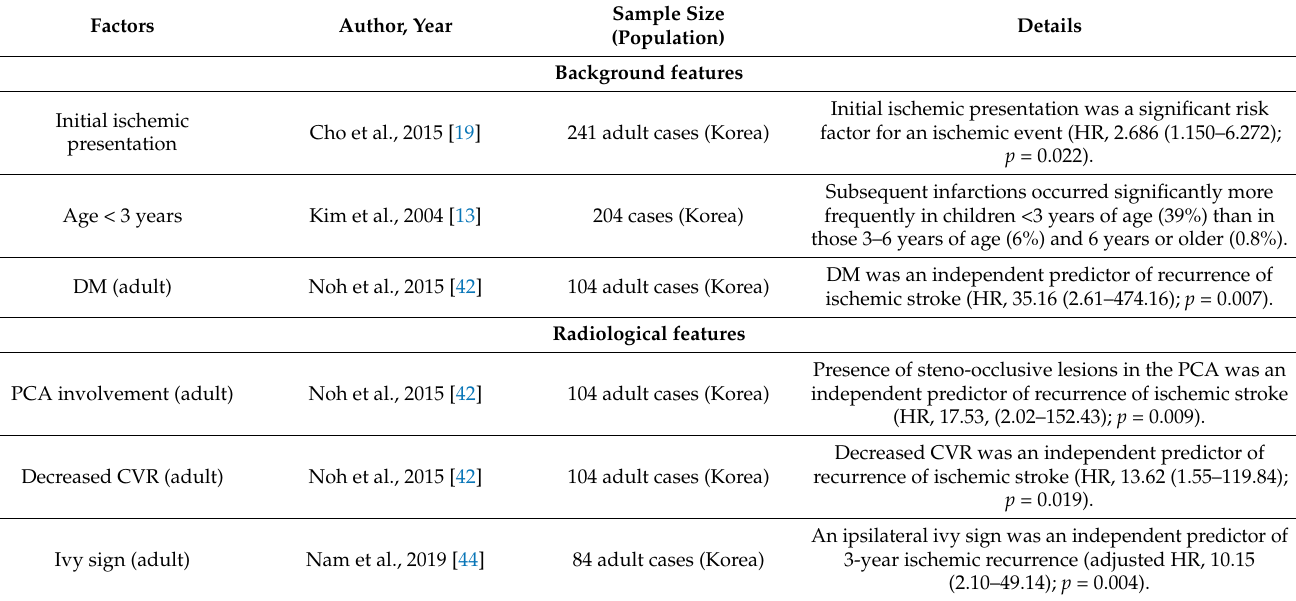
Table 2. Factors associated with recurrence of ischemic symptoms in ischemic onset moyamoya disease. Factors Author, Year